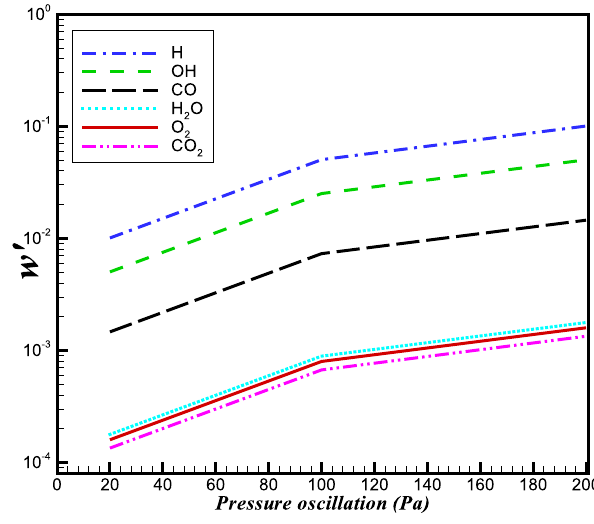
Figure 11. Relative change in the reaction rate of CH 4 at different amplitudes and a constant frequency of 5 kHz.